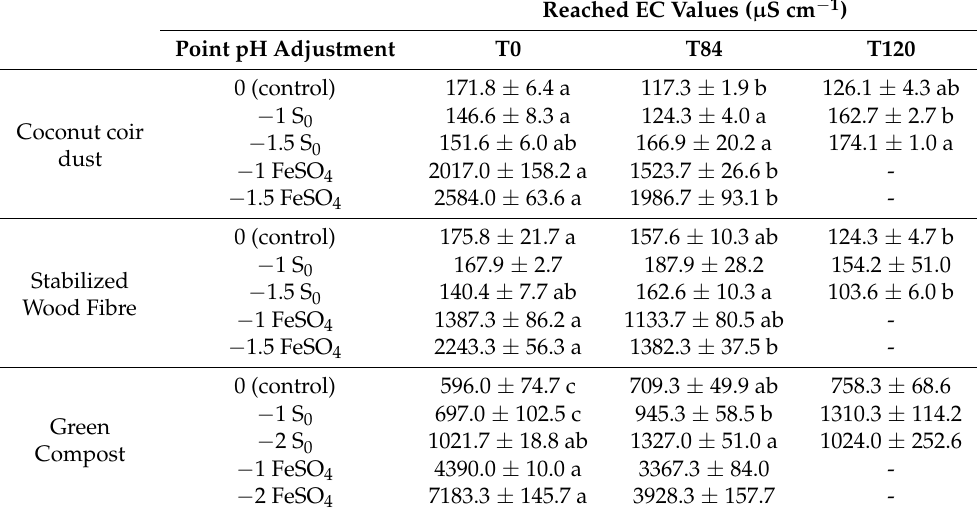
Table 2. Electrical conductivity (EC) values obtained in the climatic chamber incubation trials at different time after sulphur addition (i.e., 0 days (T0), after 84 days (T84), and after 120 days (T120)) on the three tested organic matrices and for different dosages to reach different points of pH adjustment. Data referred to T14 (after 14 days), T28 (after 28 days), and T42 (after 42 days) are not shown. Values represent mean ± standard deviation calculated of three replicates. ANOVA analysis: n.s. = not significant; different letters for each treatment indicate significantly different values among days (HSD test, p < 0.05). Reached EC Values ( µ S cm − 1 ) Point pH Adjustment